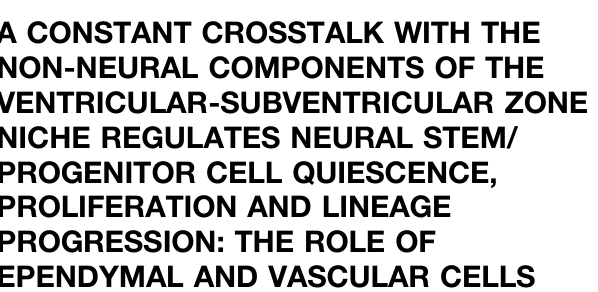
trying to elucidate how this in fl uences NPSC function and neurogenesis.